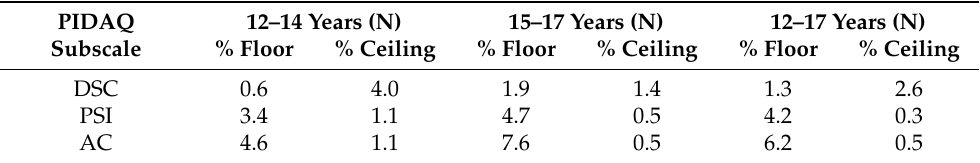
Table 11. Floor and/or ceiling effects of the